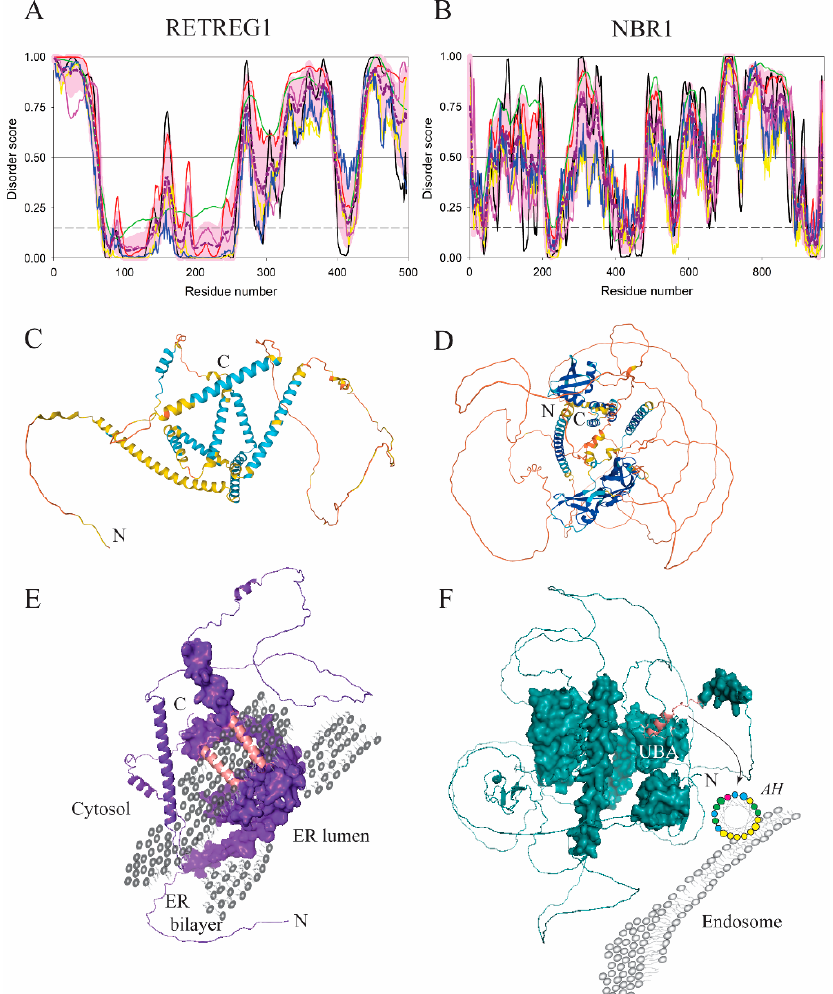
Figure 8. Intrinsic disorder in autophagy receptors. ( A , B ) Bioinformatics analysis of the amino acid sequences of RETREG1 and NBR1 showed that RETREG1 consists of the flexible N-terminus followed by a well-folded domain and long highly disordered C-terminal domain, whereas the NBR1